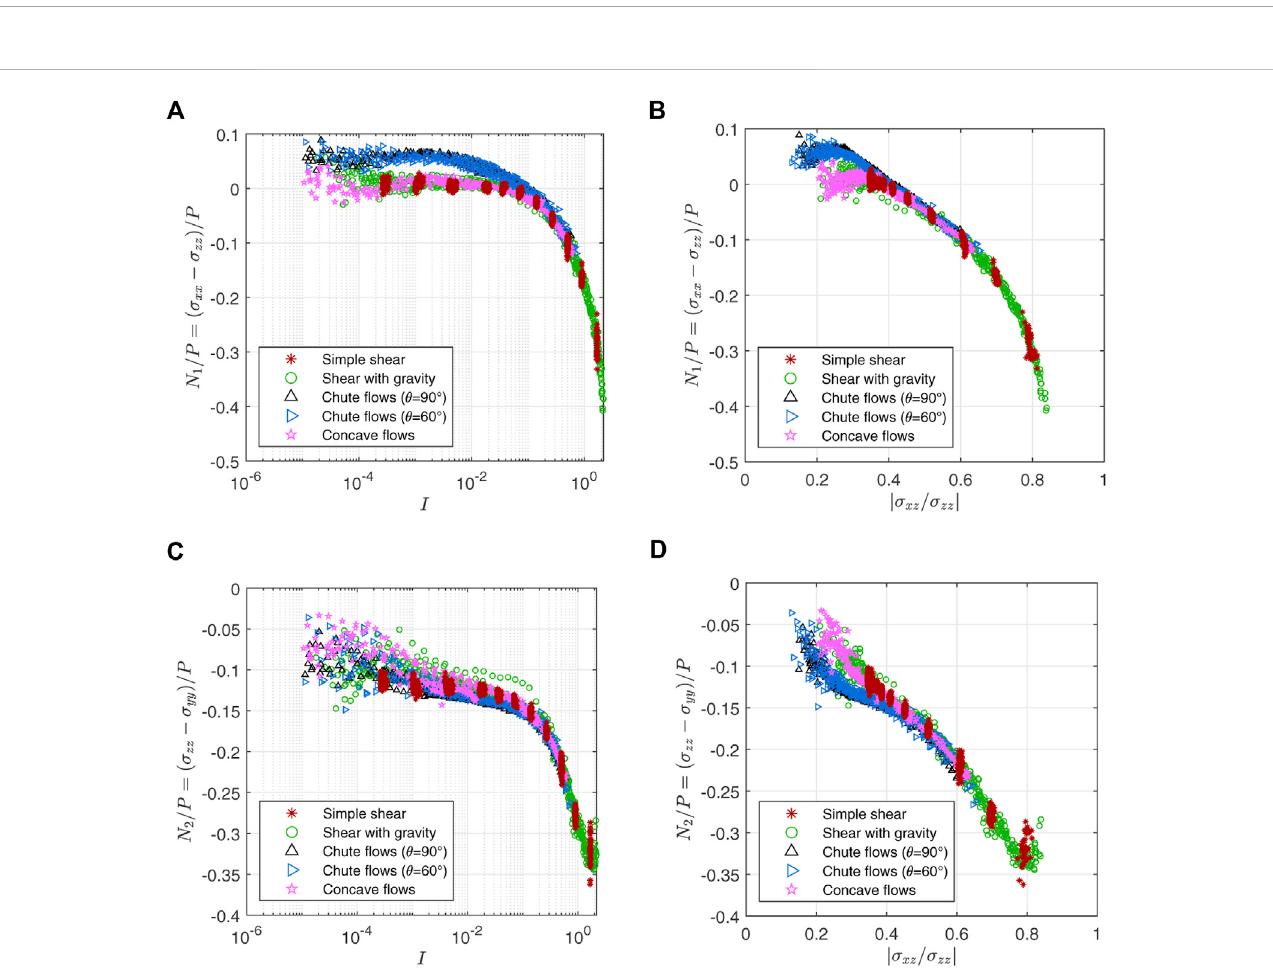
FIGURE 8 Variation of the fi rst ( N 1 ) and second ( N 2 ) normal stress differences divided by pressure: The fi rst row is N 1 / P = ( σ xx − σ zz )/ P plotted against (A) I and (B) | σ xz / σ zz |. N 1 / P isclosetozerofor I < 10 – 1 andgrowsnegativeas I increasesabove10 – 1 .Thesecondrowis N 2 / P =( σ zz − σ yy )/ P plottedagainst (C) I and (D) | σ xz / σ zz |.